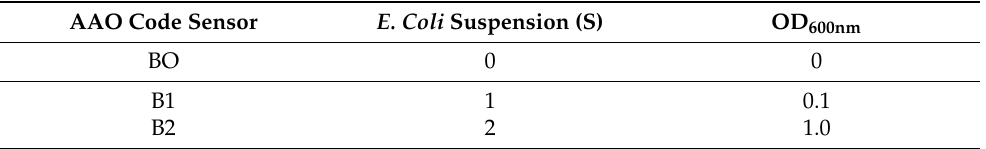
Table 3. Optical density (OD 600nm ) of Escherichia Coli BL21 (DE3) suspensions prepared to evaluate the NP-AAO sensors’ capacitance response with the amount of E. Coli present in the bacterial